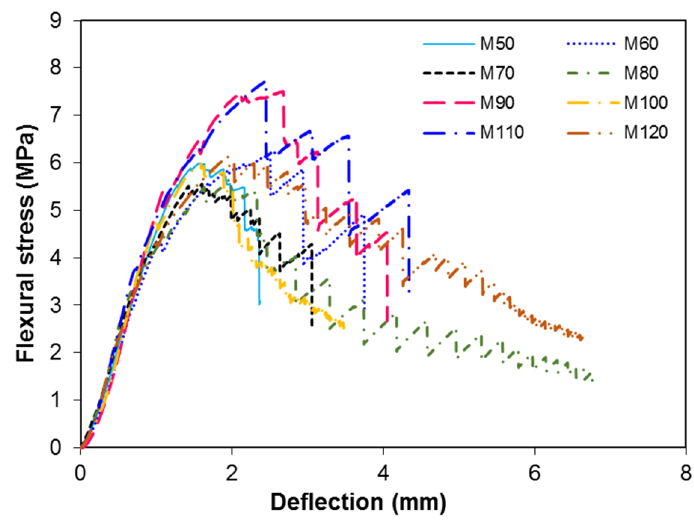
Figure 13. Flexural stress vs. deflection for different concrete mixtures.